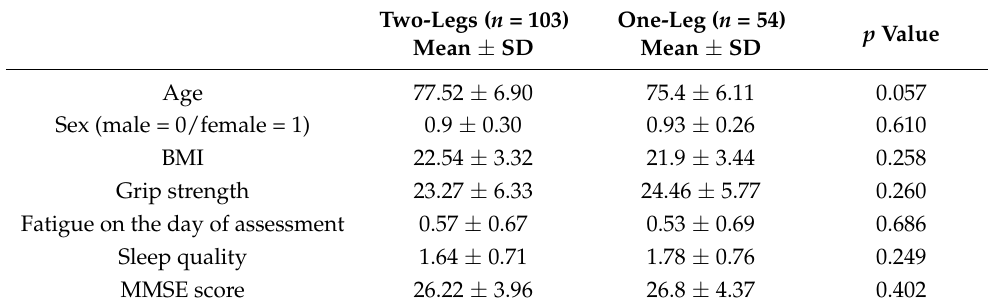
Table 1. Characteristics of individuals who underwent the two-legs or the one-leg standing tests. Two-Legs ( n = 103) One-Leg ( n = 54) p Value Mean ± SD Mean ± SD Age 77.52 ±